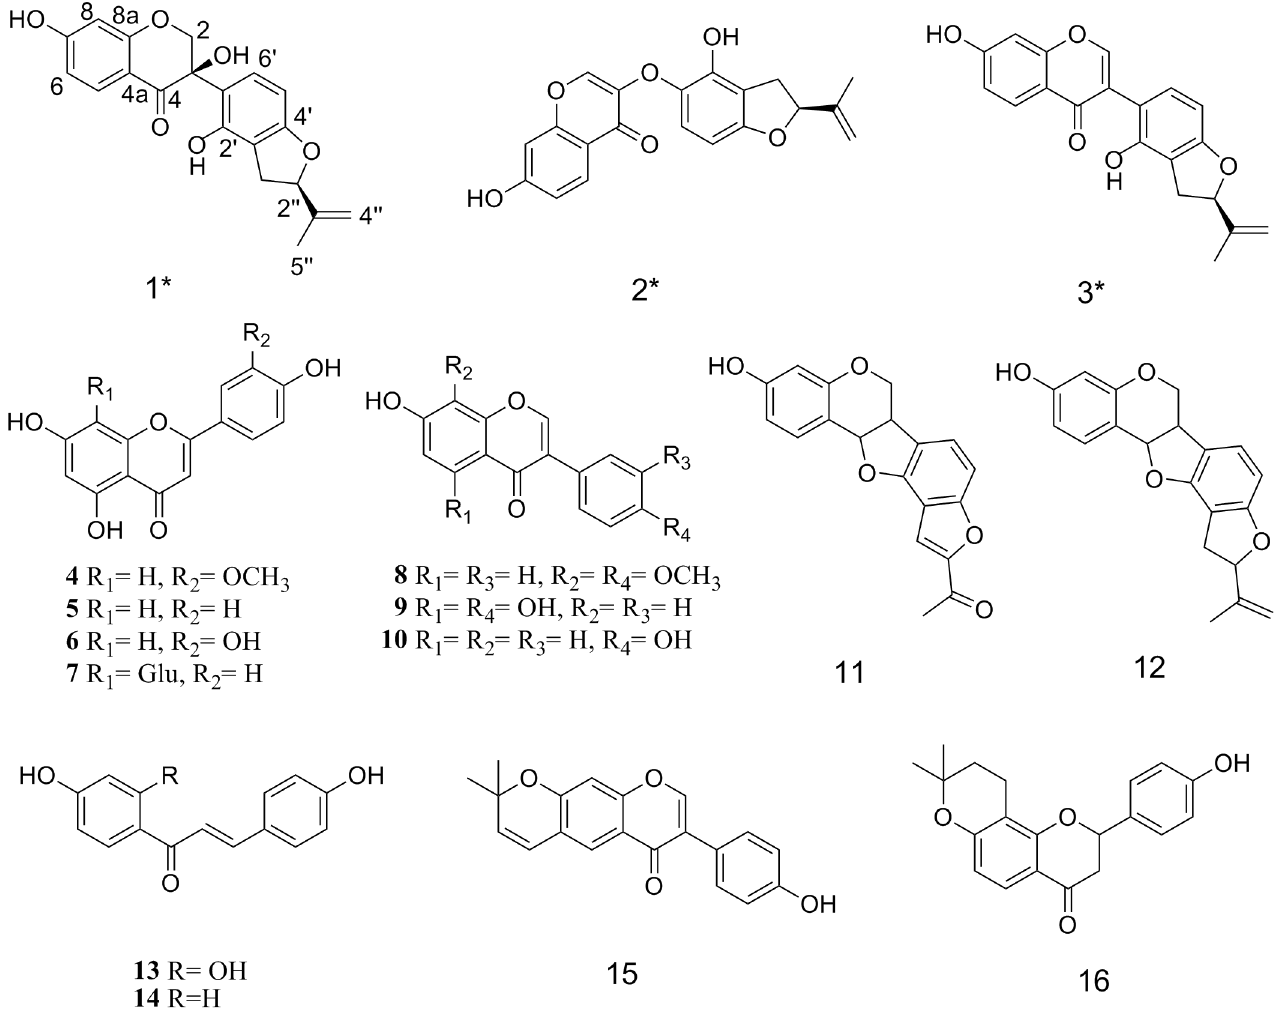
Fig 1. Structures of compounds 1 – 16 isolated from C . albida . Asterisks indicate new